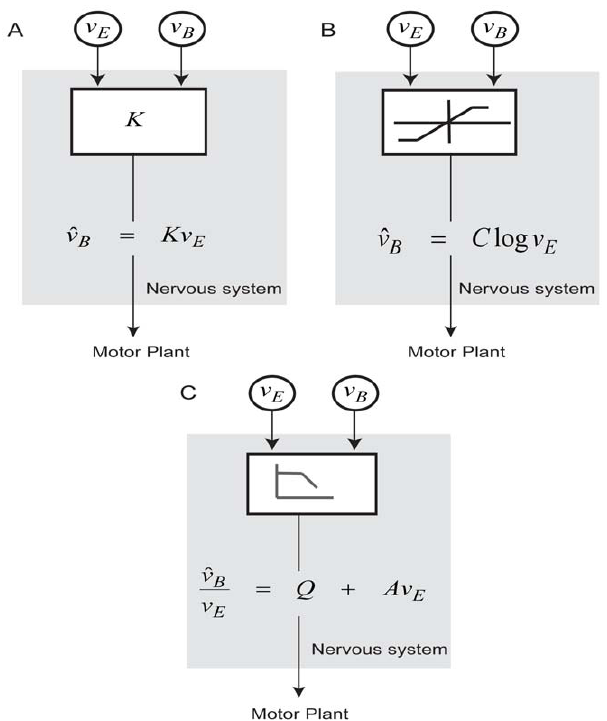
Figure 3. Alternative models of postural control. (A) Model that predicts constant gain of the postural response. (B) Model where amplitude of the postural response increases logarithmically with visual scene velocity and then saturates. (C) Model where the gain is initially constant and then monotonically decreases with the visual scene velocity. Here v E represents the visual scene velocity, v B represents the true body velocity and ^ vv B indicates the estimate of the body velocity calculated by the